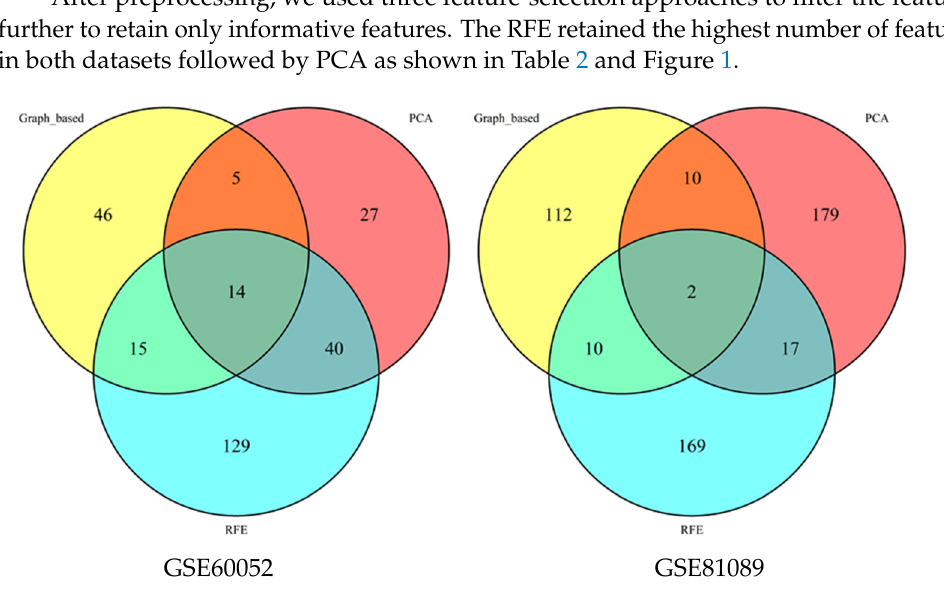
Figure 1 . Features selected by each of the methods from the two datasets. Figure 1. Features selected by each of the methods from the two